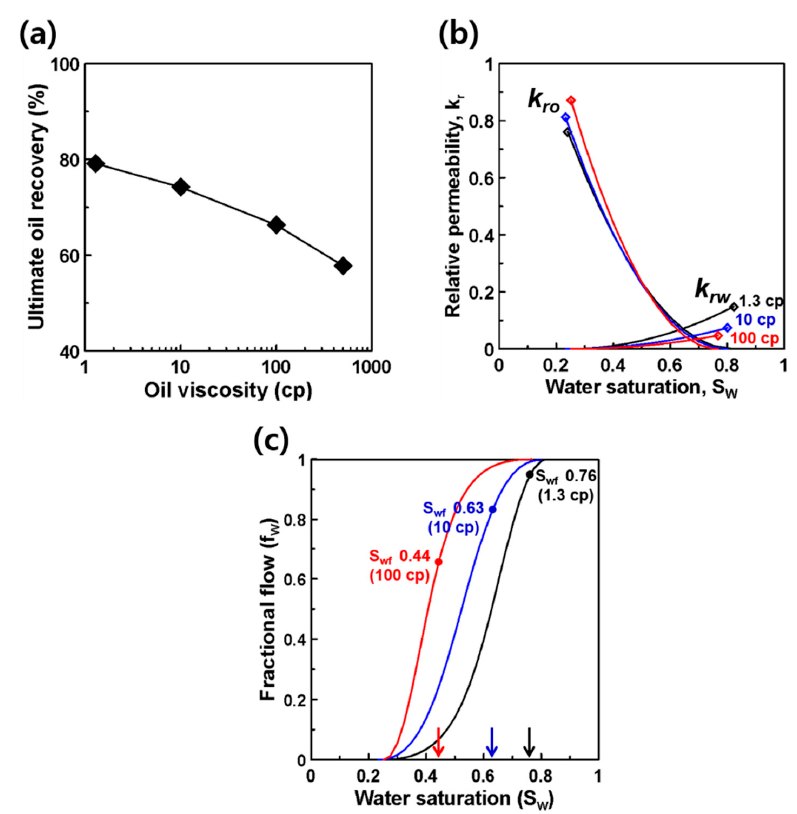
Figure 8. ( a ) Ultimate oil recoveries. ( b ) Relative permeabilities. ( c ) Fractional flow by oil viscosity. (S wf : water saturation at injection fluid breakthrough. k ro and k rw are the relative permeabilities of oil and water, respectively).